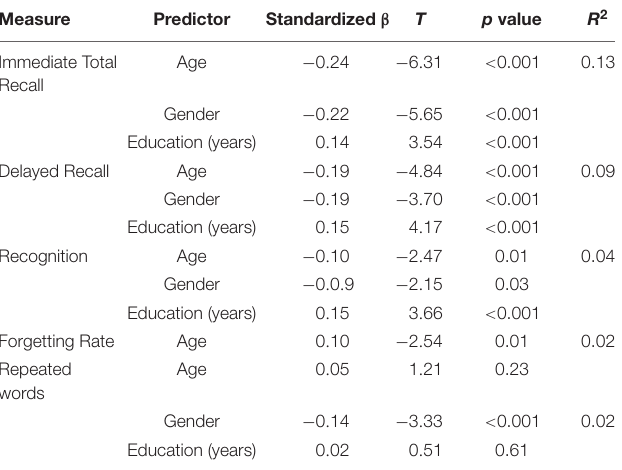
Immediate Total